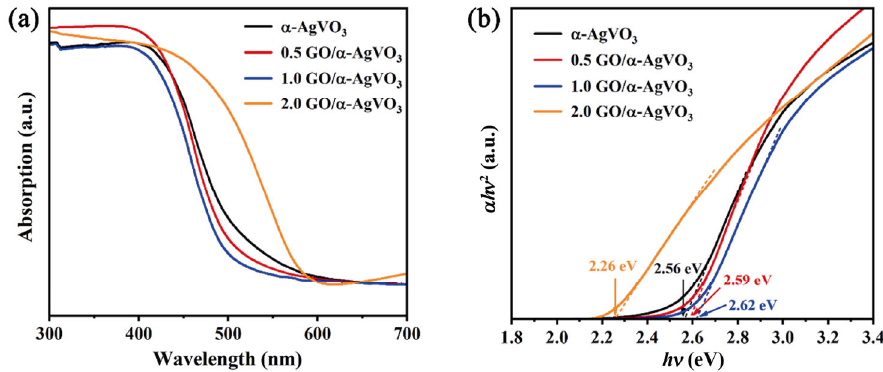
Fig. 9 (a) UV − Vis diffuse reflectance spectra and (b) Kubelka − Munk plots of α -AgVO 3 and GO/ α -AgVO 3 nanocomposites with different GO contents (0.5, 1.0, and 2.0 wt%).